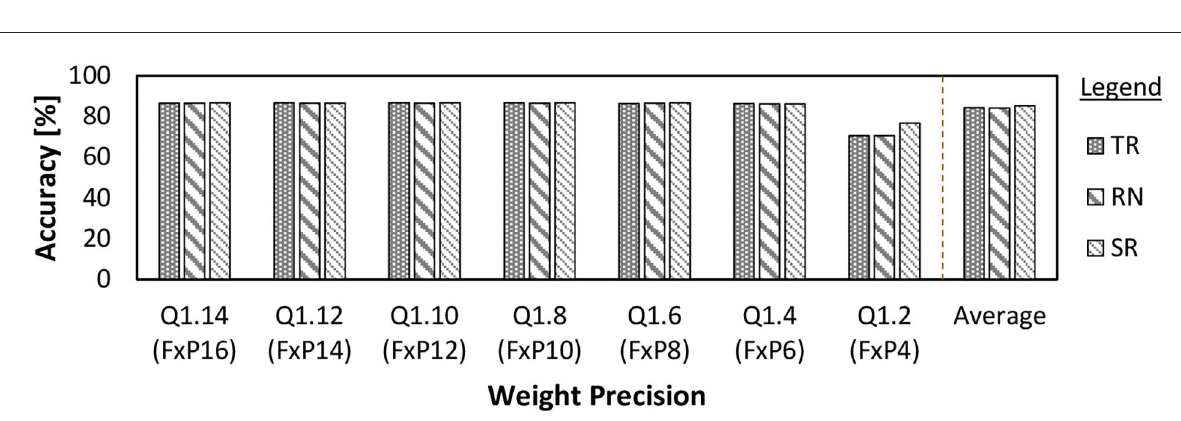
FIGURE6 The accuracy of a 900-neuron network on the MNIST across different precision levels and rounding schemes, i.e., truncation (TR), round to the nearest (RN), and stochastic rounding (SR). Here, we follow the definition of TR, RN, and SR from the study of Hopkins et al. (2020). Note that the fixed-point format Qi . f can also be represented as FxP(1+ i + f ). These results show that employing TR on top of the FxP8 precision leads to competitive accuracy as compared to other rounding schemes (i.e., RN and